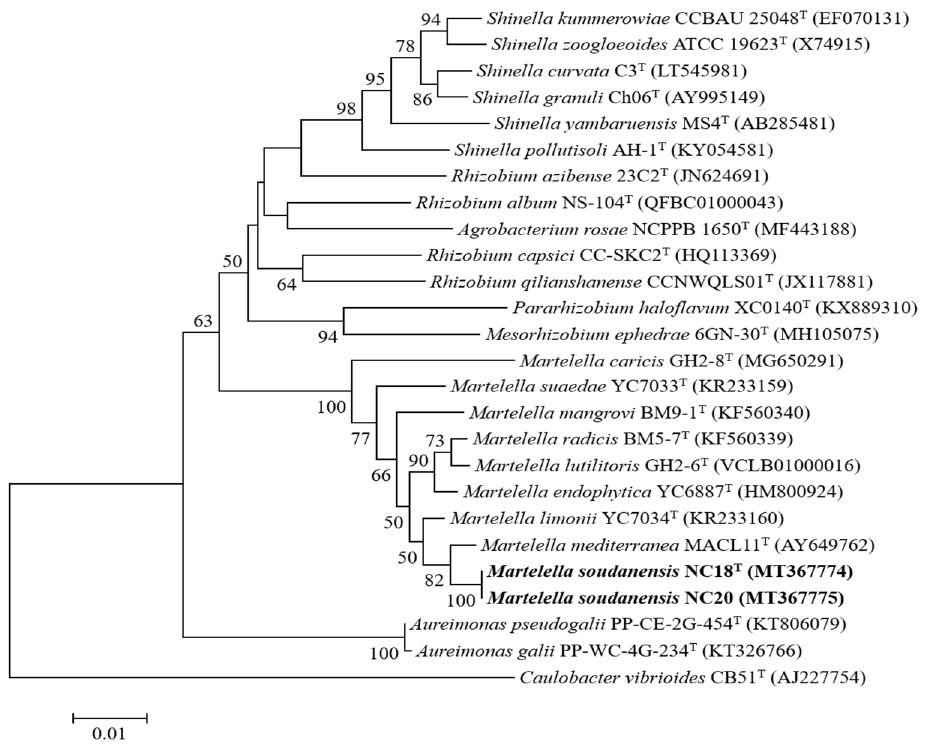
Figure 1. Phylogenetic tree based on 16S rRNA gene sequences of strains NC18 T and NC20 with other related taxa using 1393 bp sequence. Evolutionary distances calculated using the Jukes–Cantor model. Evolutionary history was inferred using the neighbor-joining method. Bootstrap values (tested as 1000 replications) above 50% are shown next to branches. Sequence of Caulobacter vibrioides CB51 T used as outgroup. Bar, 0.01 nucleotide substitution per position. The MLSA tree also agreed with the taxonomic positions of the two strains as shown by